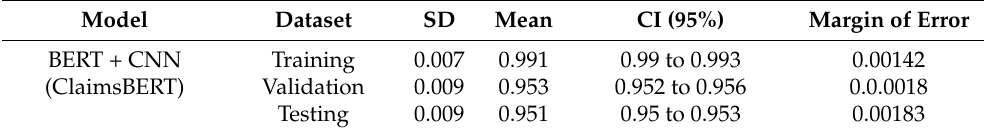
Table 8. ClaimsBERT Accuracy Performance Results for Investigating the Seed Randomness Effect.